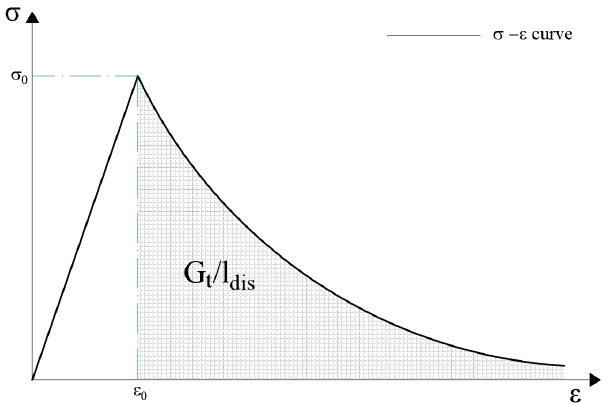
Figure 1. Uniaxial stress laws.